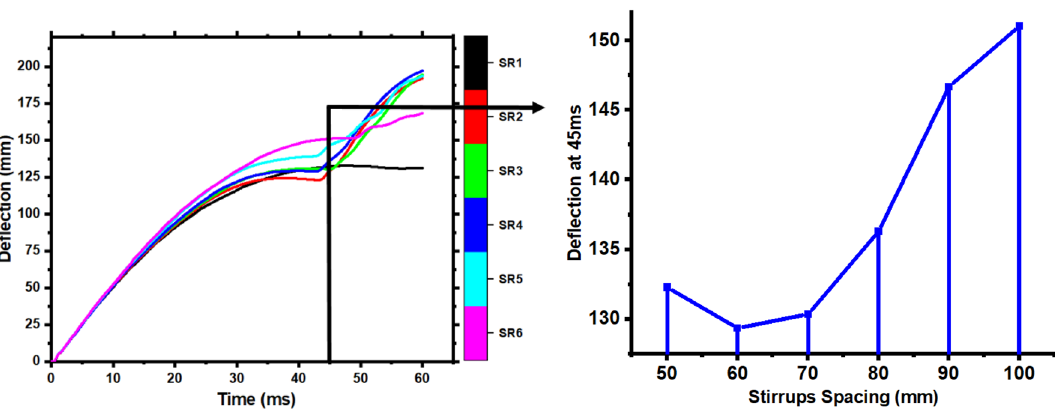
Figure 20. Deflection time history curve of members and comparison of deflection with various stirrup ratios at 45